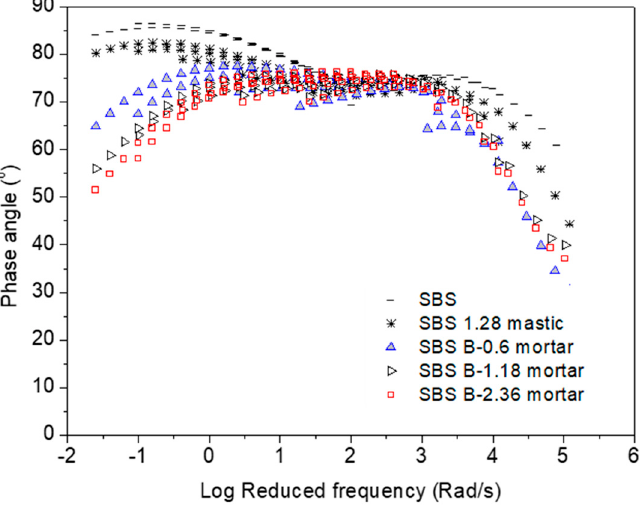
Figure 6. Phase angle master curves of AC-13 based asphalt materials including SBS modified asphalt binder, mastic and mortar at a reference temperature of 60 °C.